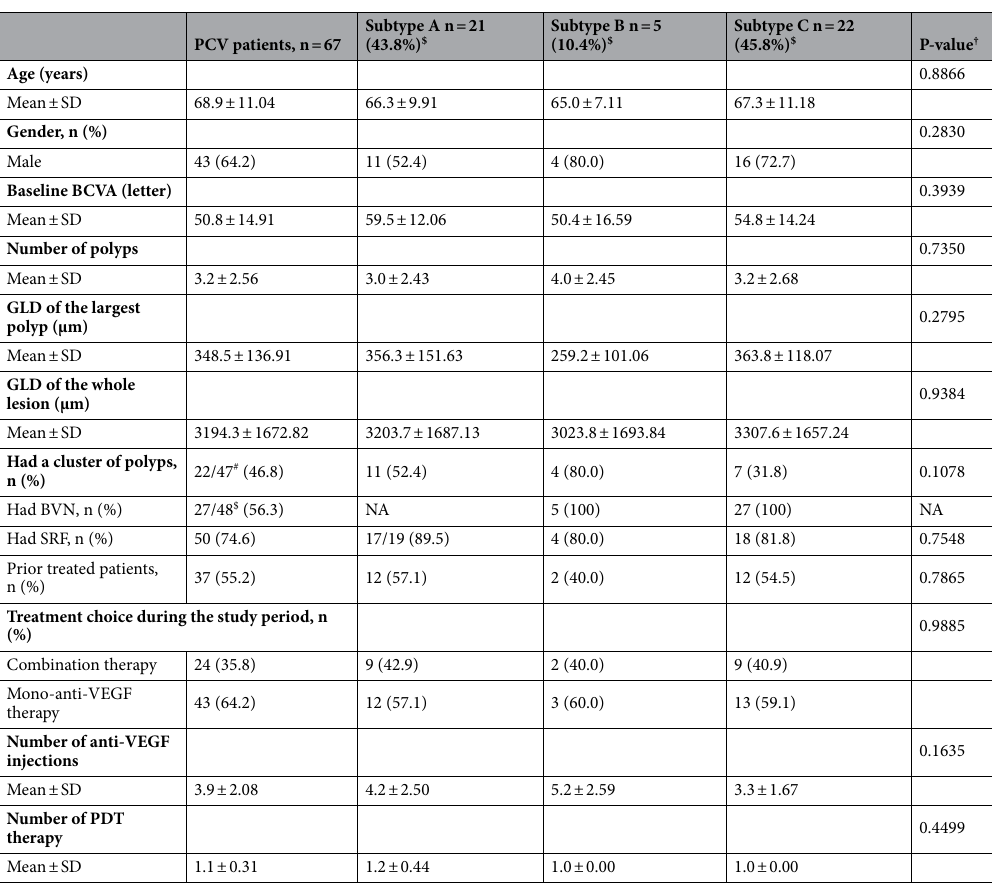
Table 1. Demographic and clinical characteristics of the overall study population and PCV subtypes. PCV polypoidal choroidal vasculopathy, SD standard deviation, GLD greatest linear dimension, NHI national health insurance, VEGF vascular endothelial growth factor, SRF subretinal fluid, BVN branching vascular network, NA not applicable, PDT photodynamic therapy. # Only 47 patients with polyps were recorded. $ Patients whose data were not gradable were not included in the calculation of PCV subtype distribution (not gradable: n = 19). † One-way ANOVA or Chi-square tests were applied for continual or categorical variables to compare differences between